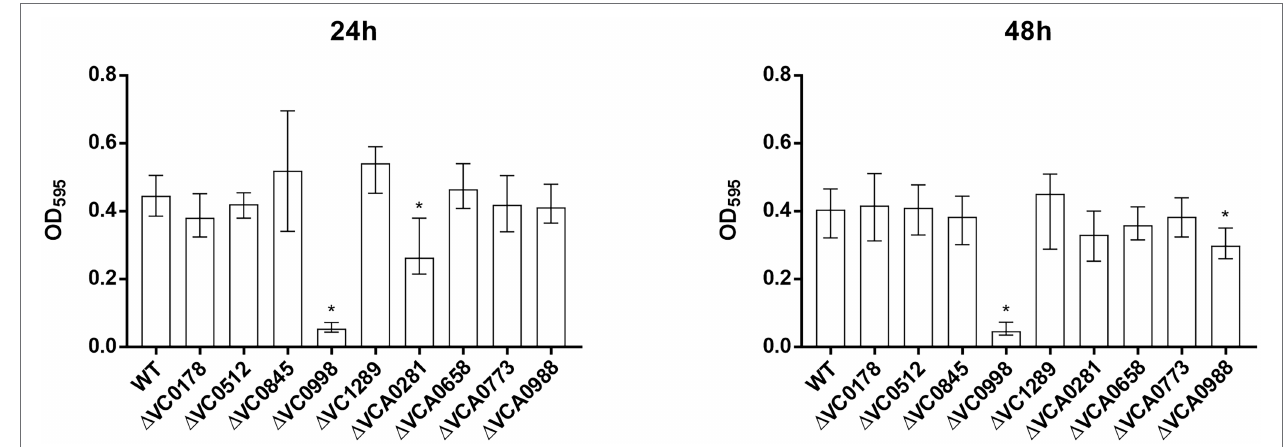
FIGURE 3 | Static biofilm formation of ibr gene deletion mutants compared to the WT. Biofilms of WT and deletion mutants were quantified after 24 and 48 h. The biofilm formation capacity was assayed under static conditions by crystal violet staining and subsequent determination of the OD 595 . Shown are the medians ± IQR from at least 16 independent measurements. An asterisk indicates a significant difference to the WT (* p < 0.001 by Kruskal–Wallis test followed by post hoc Dunn’s multiple